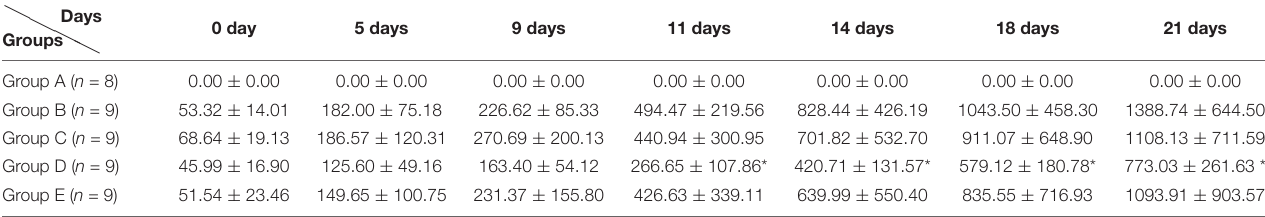
TABLE 1 | The tumor growth volume of each group was compared at different time ( n = 9). (cid:72) (cid:72) (cid:72) (cid:72)